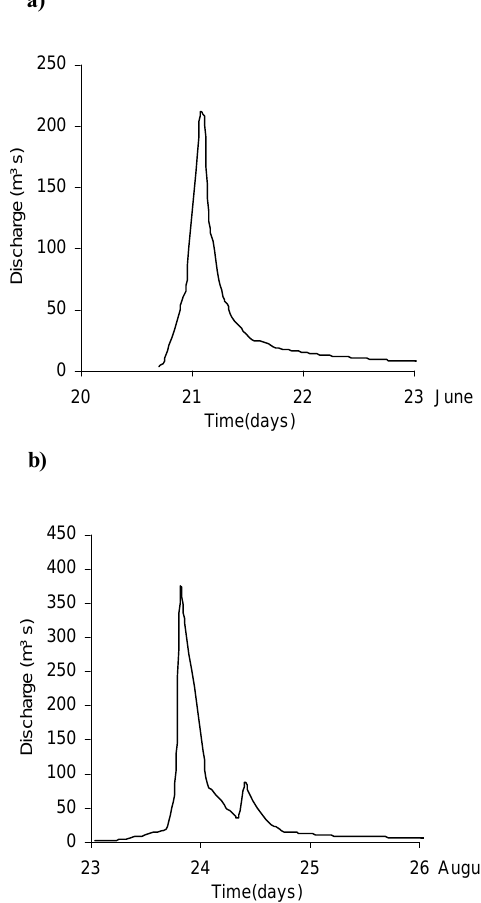
Fig. 5. Flash-flood hydrographs recorded at: (a) Criste¸stii-Ciceului streamgauge station – June 2006 Ili¸sua event; (b) ¸Simone¸sti stream- gauge station – August 2005 Feernic event (source of data: Roma- Figure 5. Flash-flood hydrographs recorded at: (a) Criste ş tii-Ciceului streamgauge station - nian Waters National Administration, June 2006 Ili ş ua event; (b) Ş imone ş ti streamgauge station - August 2005 Feernic event (source of data: Romanian Waters National Administration, RWNA).